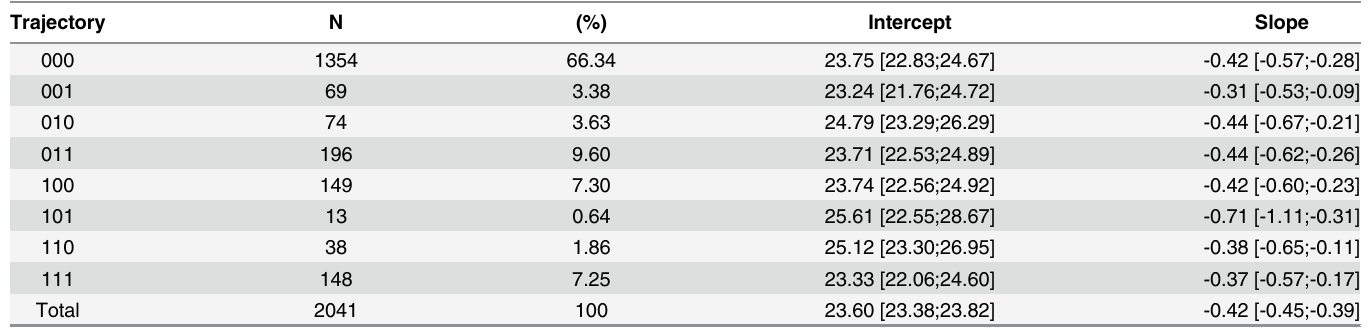
Note : 95% con fi dence interval in brackets. Trajectories are described by 1 for exposure to low OP, and 0 for no exposure. Averaged across countries and predicted for the level of the cohorts 1931 –